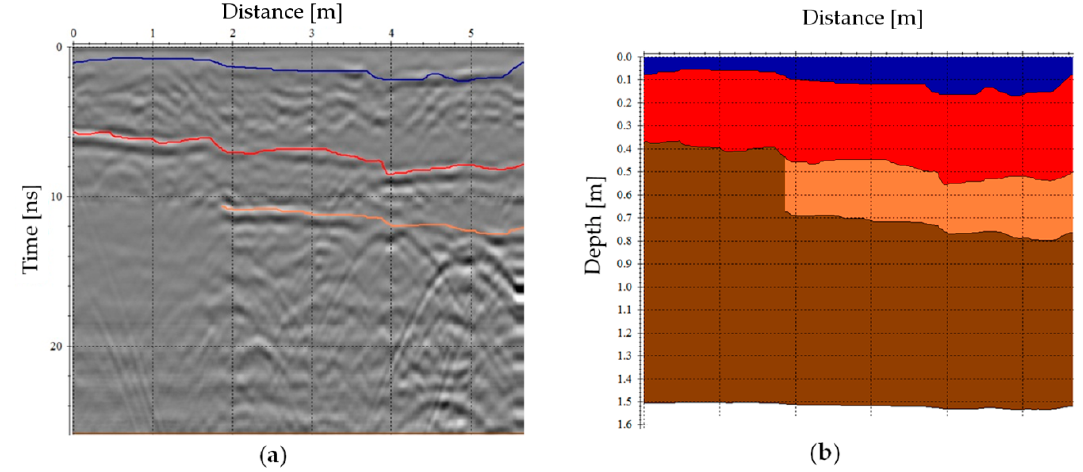
Figure 14. EMW velocity estimation on the 5th profile using 900 MHz antenna. ( a ) Sub-horizontal GPR echoes indicated by lines between pavement layers; ( b ) velocity field with values in individual layers (0.132 m / ns: blue (AC 8, AC 22), 0.121 m / ns: red (base course), 0.120 m / ns: orange (subbase course), 0.080 m / ns: brown (subgrade soil)).